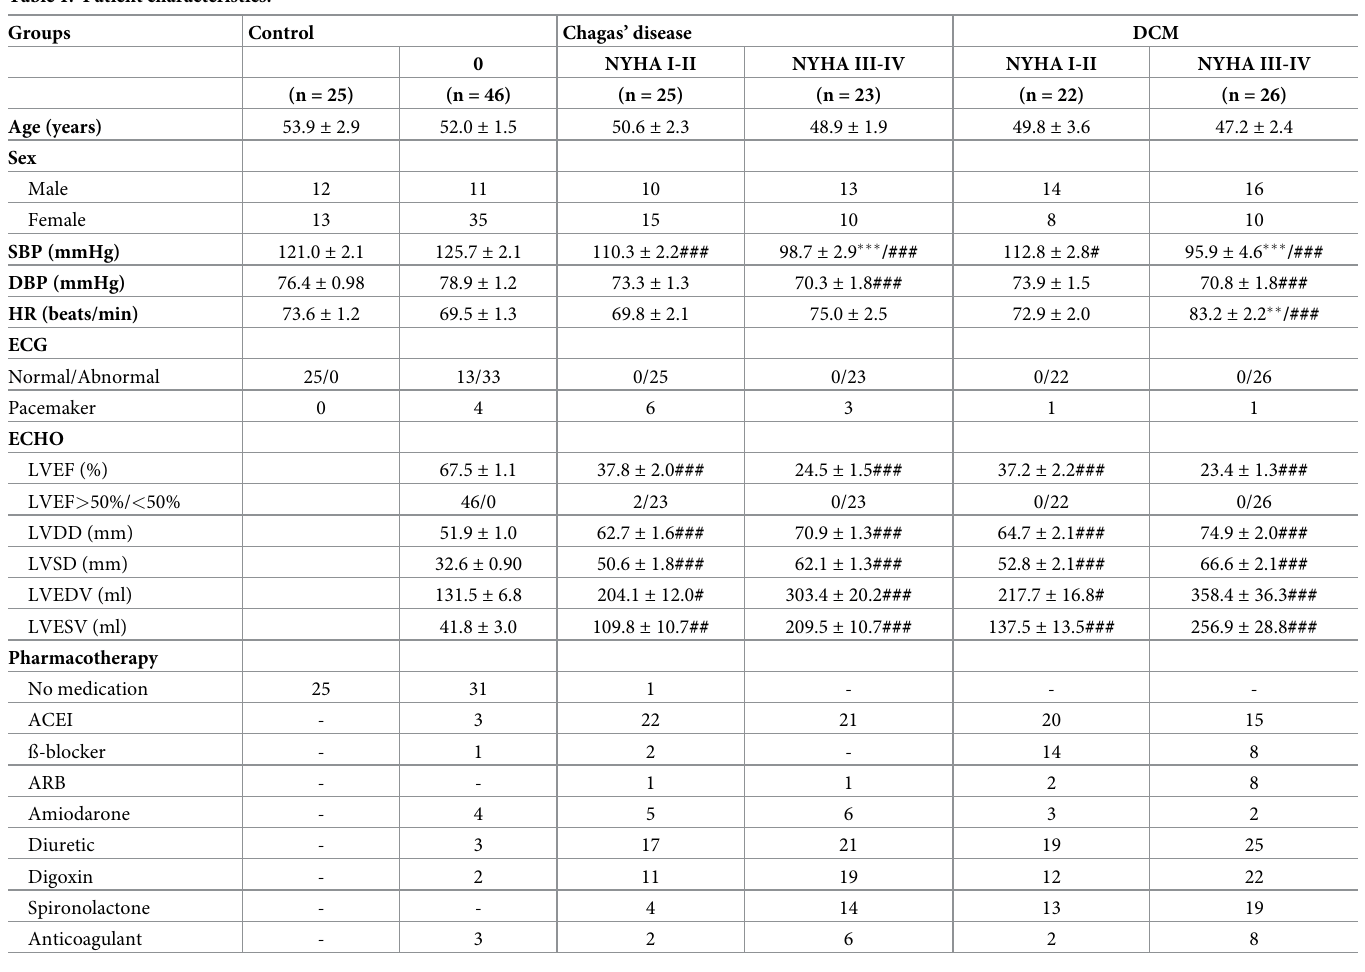
Table 1. Patient